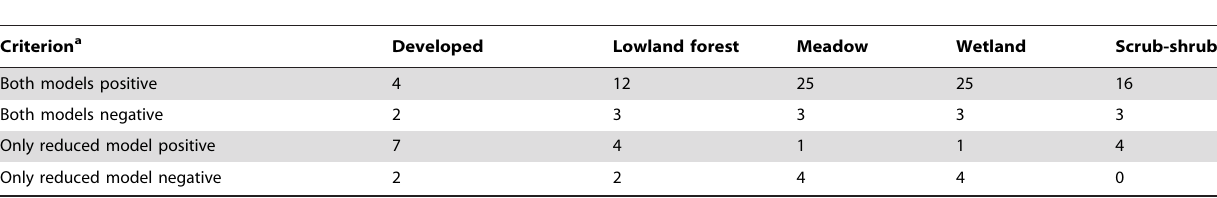
Table 3. Numbers of species with significant associations between occupancy and landcover variables under two alternative models (landcover only and global models) based on point count surveys throughout the Patuxent Wildlife Research Refuge, Maryland,